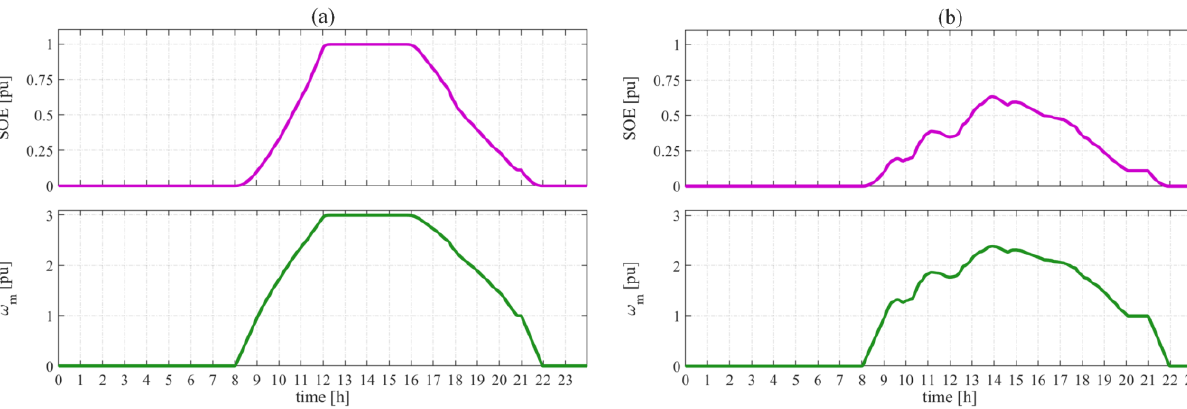
( a ) ( b ) Figure 16. Losses evolutions achieved over a real operating scenario: ( a ) @360 V and ( b ) @720 V (case C1). Figure 17. Losses evolutions achieved over a real operating scenario @360 V and @720 V (case C2). Considering case C1 at first (Figures 13a – 15a), it can be seen that FESS is started at 8:00, when PV production already overcomes the load demand, as detectable in Figure 13a; the FESS is then charged at reduced torque and power rating in order to achieve its rated speed not before 1 h (Figure 15a); in this regard, the pre-charging stage, which could be accomplished in approximately 15 min (Figure 10), has been slowed down properly in